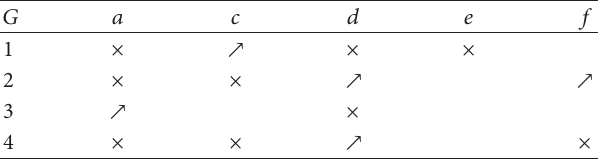
Table 3: The arrow relation ↗ of (𝐺,𝑀, 𝐼)